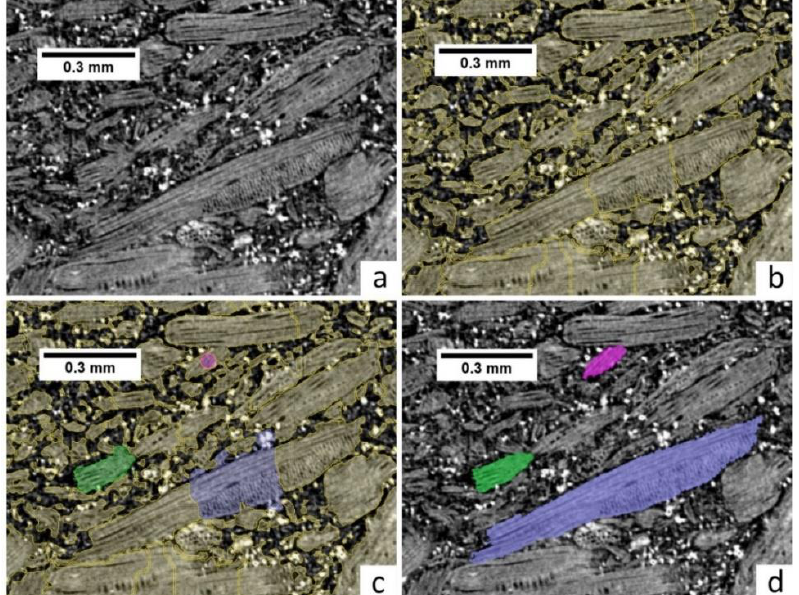
Figure 1. Labeling and restoration of wood particles. ( a ) Original grayscale tomogram; ( b ) thresholded volume showing segments (yellow); ( c ) three different types of labels: blue, a wood particle with more than one segment; green, a particle with only one segment; magenta, an unseparated particle that shared a segment with another particle. ( d ) Results of the manual restoration of labeled particles.